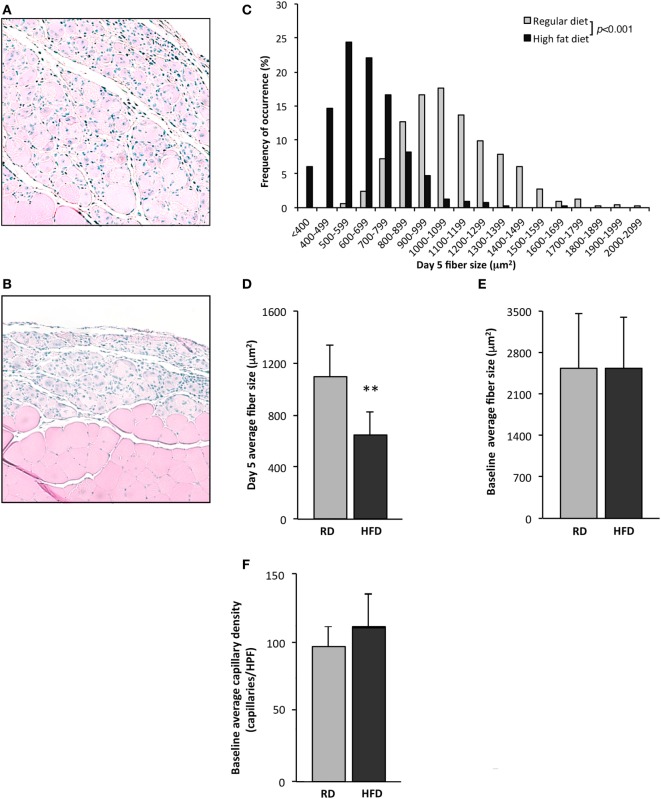
Exposure to a high-fat diet limits skeletal muscle regeneration. Twenty-two-week old mice fed a high-fat diet (HFD) for 16 weeks were compared to similarly aged mice on a regular diet (RD). Quantification of uninjured fiber size and regenerating (centrally nucleated) myofiber size in tibialis anterior muscles 5 days after cryoinjury for control mice receiving an RD (n = 5 mice) (A) was compared with mice fed an HFD (n = 5) (B). Representative figures for regenerating fibers on day 5 following injury as seen on H&E stained sections are presented in this figure and demonstrate significant differences in regeneration. Regenerating fiber size at day 5 following injury, fiber size (binned by 100 µm2 increments) (C), or as average fiber cross-sectional area (D), was significantly larger in the group fed RD as compared to HFD. There is no difference in cross-sectional fiber area of uninjured muscle (n = 5) (E), or capillary density (n = 4) (F). p-Values determined by Kruskal–Wallis test with step-down Bonferroni method for panel (C). p-Values otherwise calculated by Student’s t-test (**p < 0.01).